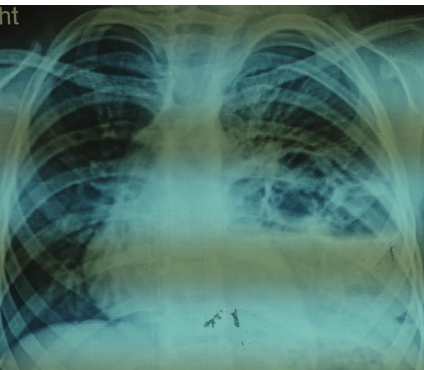
Figure 1: X-chest showing an opacity in the left lower lobe of the lung.